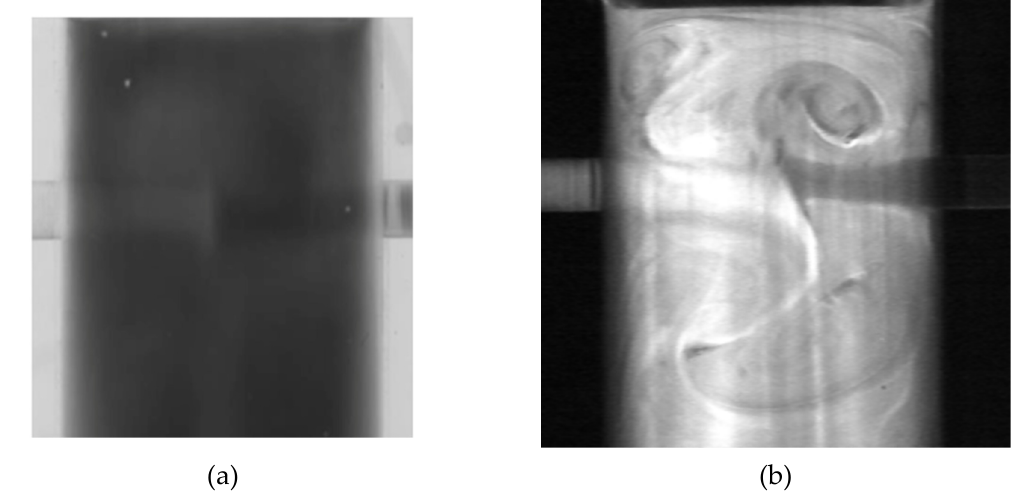
Figure 1. Flow visualization in confined impinging jets of mixing of two dissimilar fluids ( a ) with a viscosity ratio of 4 and without refractive index matching and ( b ) with a viscosity ratio of 2 and with refractive index matching.